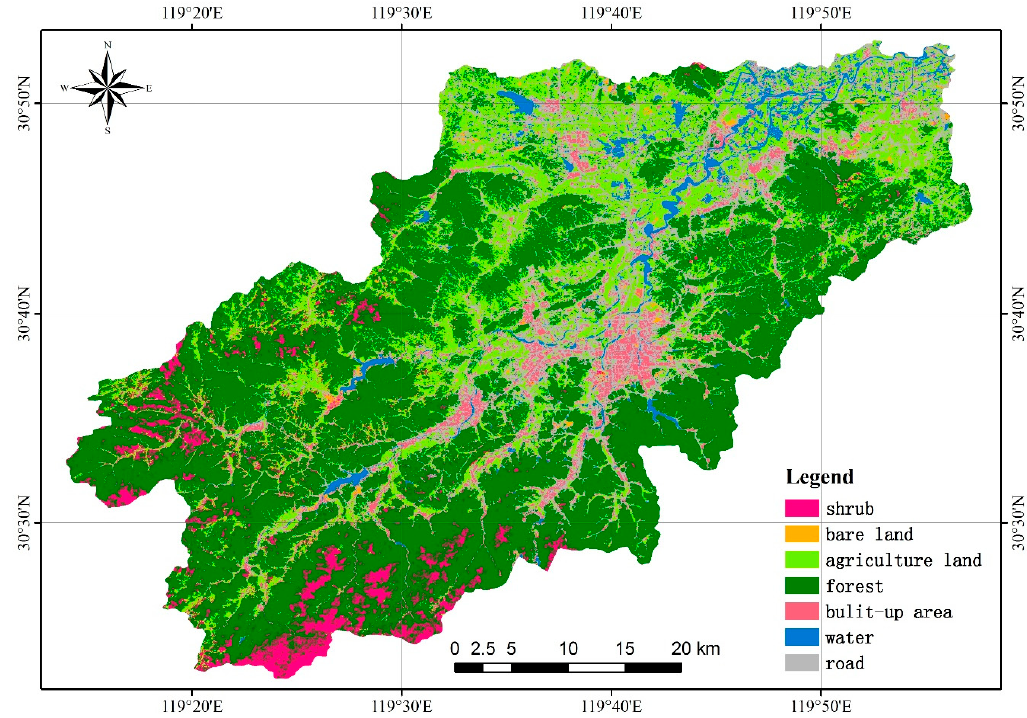
Figure 8. LULC mapping generated by adding EAPs and GLCM with spectral bands of Sentinel-2 imagery sharpened by high-pass filter (HPF) fusion.